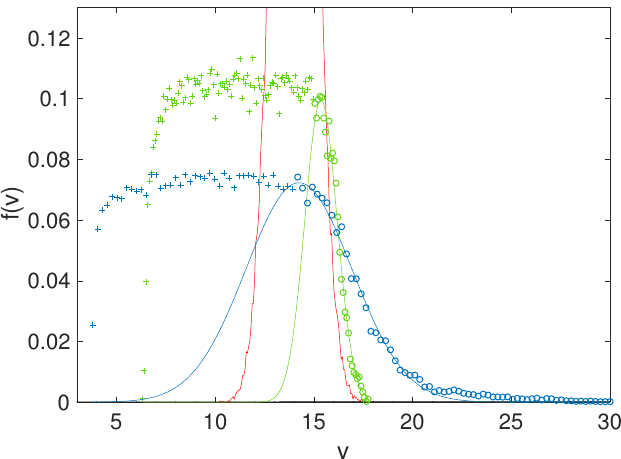
Figure 15. Velocity distribution f ( v ) of the beam for a quasi-homogeneous plasma with ∆ n = 0.001, at (i) ω p t = 0 (truncated, red), (ii) ω p t = 47,500 (green) and (iii) ω p t (cid:39) 170,000 (blue). Points (circles) provided by the simulations are fitted by Gaussian distributions (solid lines) for the beam accelerated tail, taking into account only velocities v larger than the initial beam velocity v b . The points excluded from these fits and representing the decelerated plateau are labeled by crosses. Velocities are normalized by the electron thermal velocity v T . (Reproduced with permission from